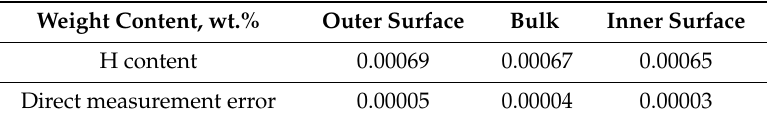
Table 5. H content in the untreated steel specimens.